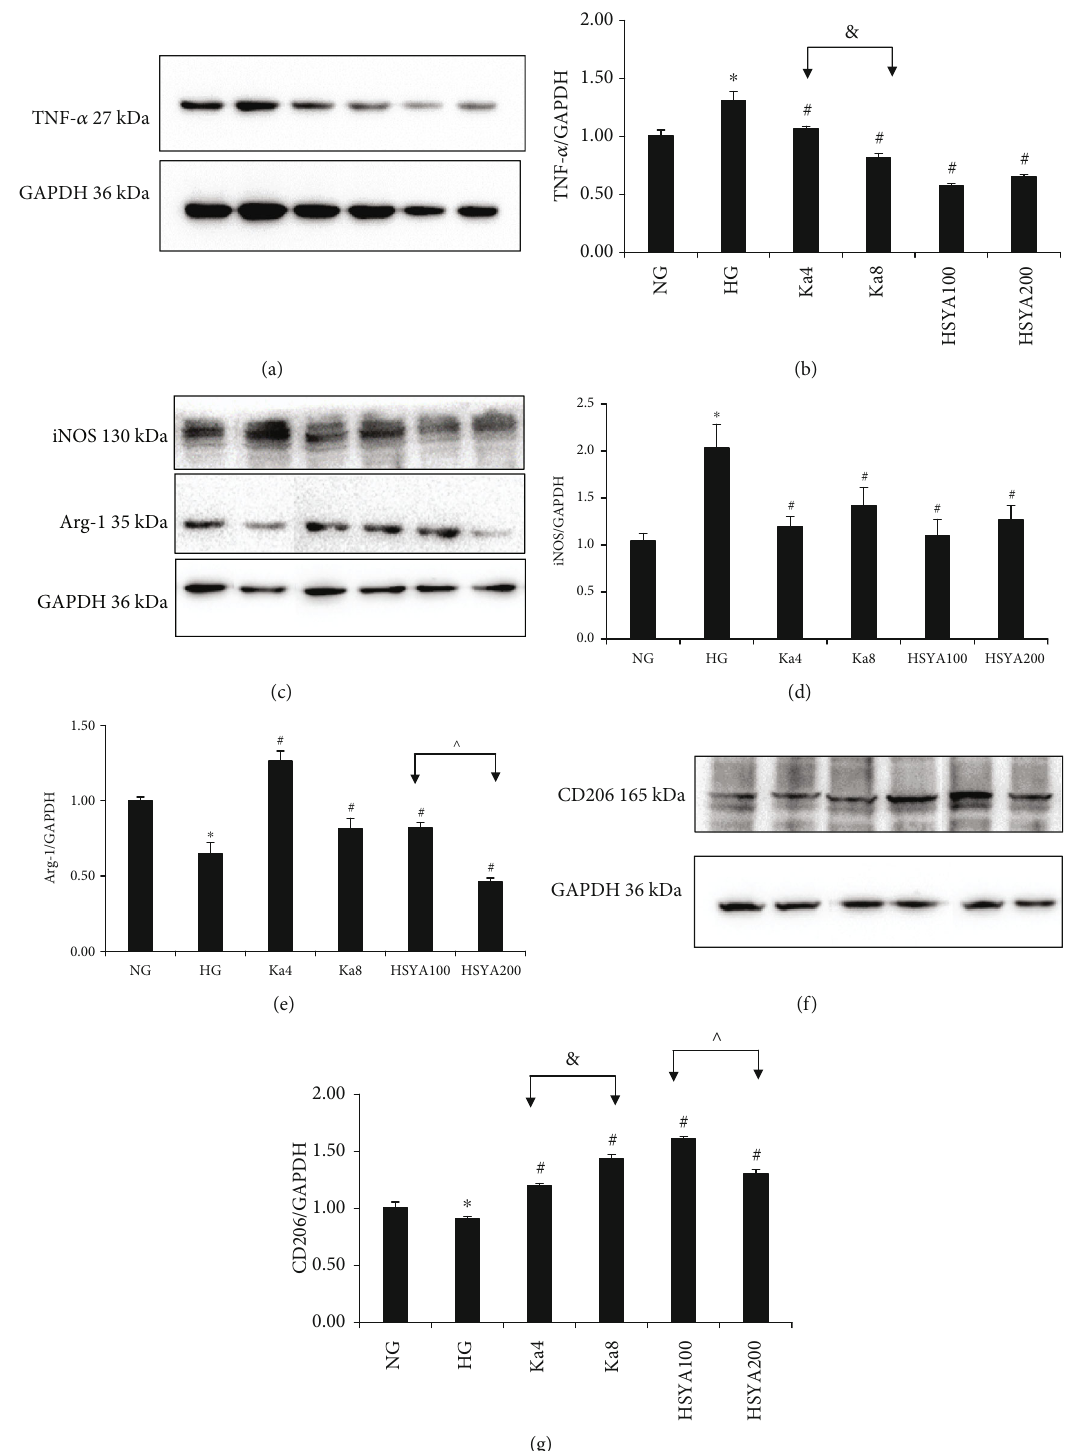
Figure 3: The e ff ects of Ka and HSYA on iNOS, TNF- α , Arg-1, and CD206 protein expressions in HG-induced macrophages as measured by Western blotting. TNF- α protein expression was shown in (a) and represented in (b). iNOS and Arg-1 protein expressions were shown in (c) and represented in (d, e). CD206 protein expression was shown in (f) and represented in (g). All results were expressed as a ration with respect to control and represented as the mean ± SD in triplicates. ∗ p < 0 : 05 versus NG. # p < 0 : 05 versus HG. & p < 0 : 05 , Ka4 versus Ka8. ^ p < 0 : 05